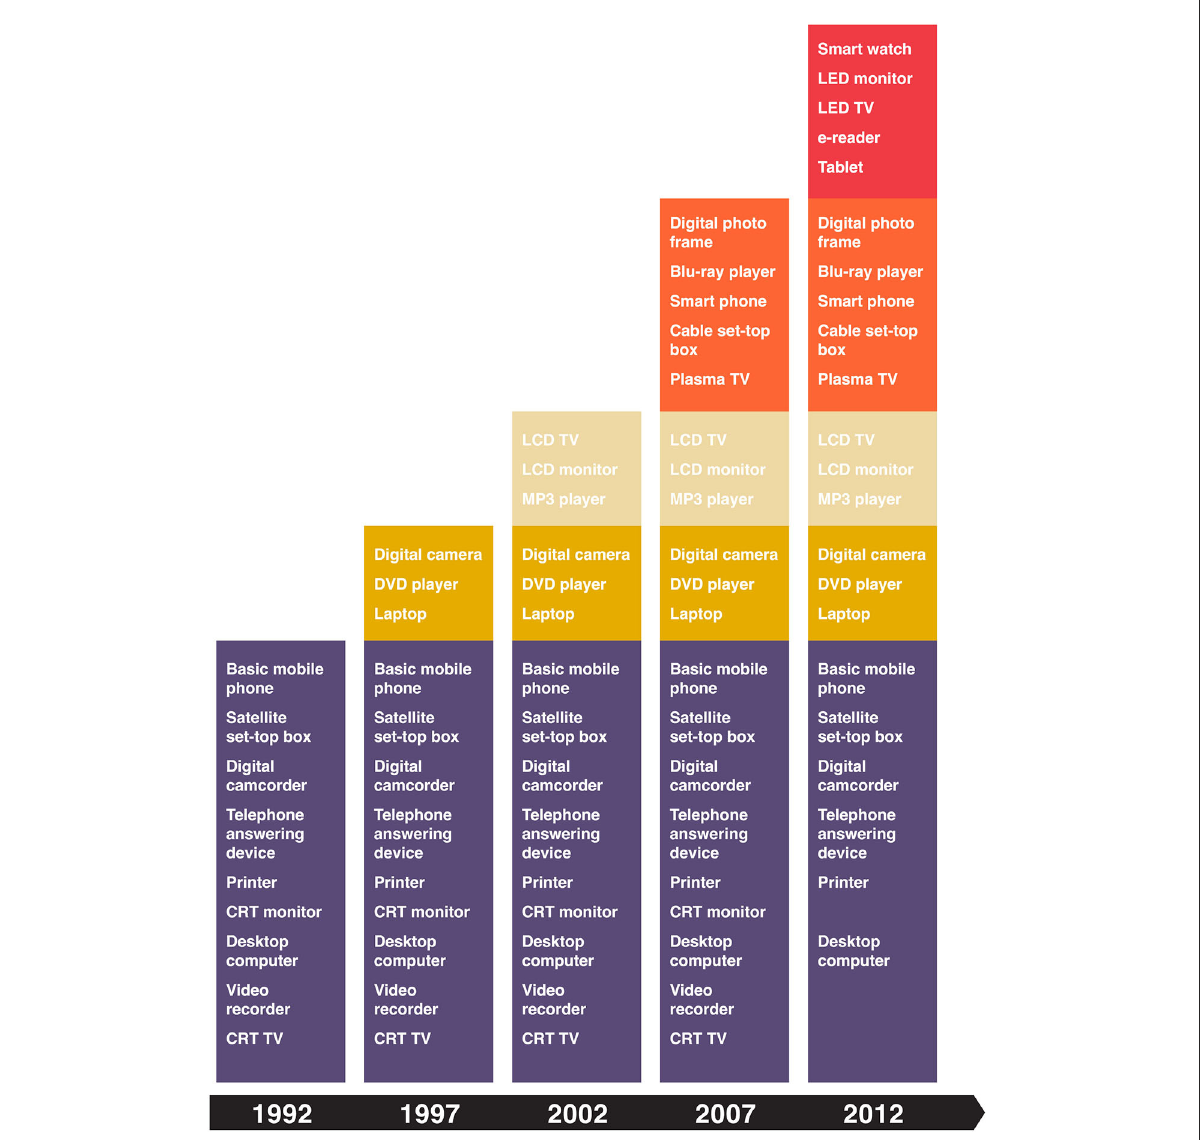
FIGURE2 Illustration of the introduction of new product as a function of time (not exhaustive) as illustrated by electronic devices. Colors indicate new waves of products. Note that some products progressively phase-out (CRT TVs and monitors, video recorders) and are removed for more recent years (data source: Ryen et al., 2015; Althaf et al.,